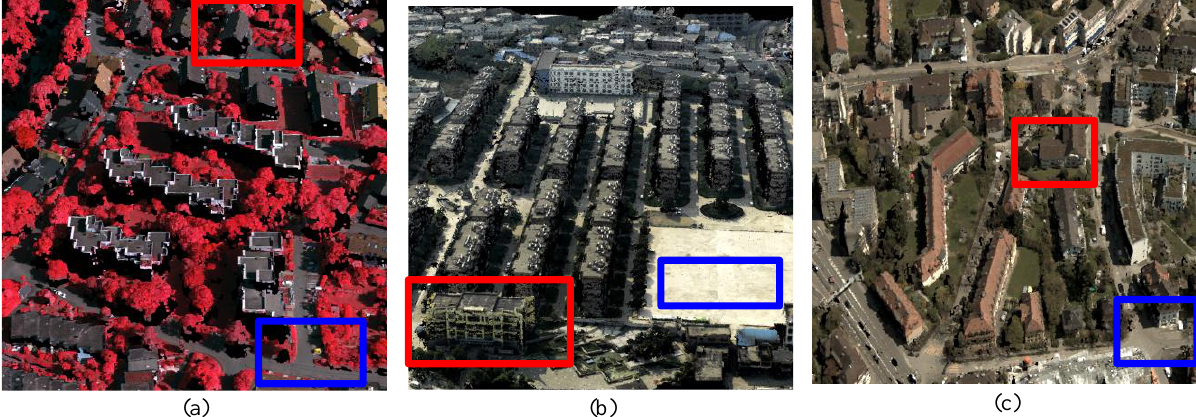
Figure 5. Overview of the point clouds in the evaluated areas. (a) Vaihingen dataset, (b) Jinyang dataset, and (c) Zurich dataset. The red and blue rectangles show the evaluated building and road areas,